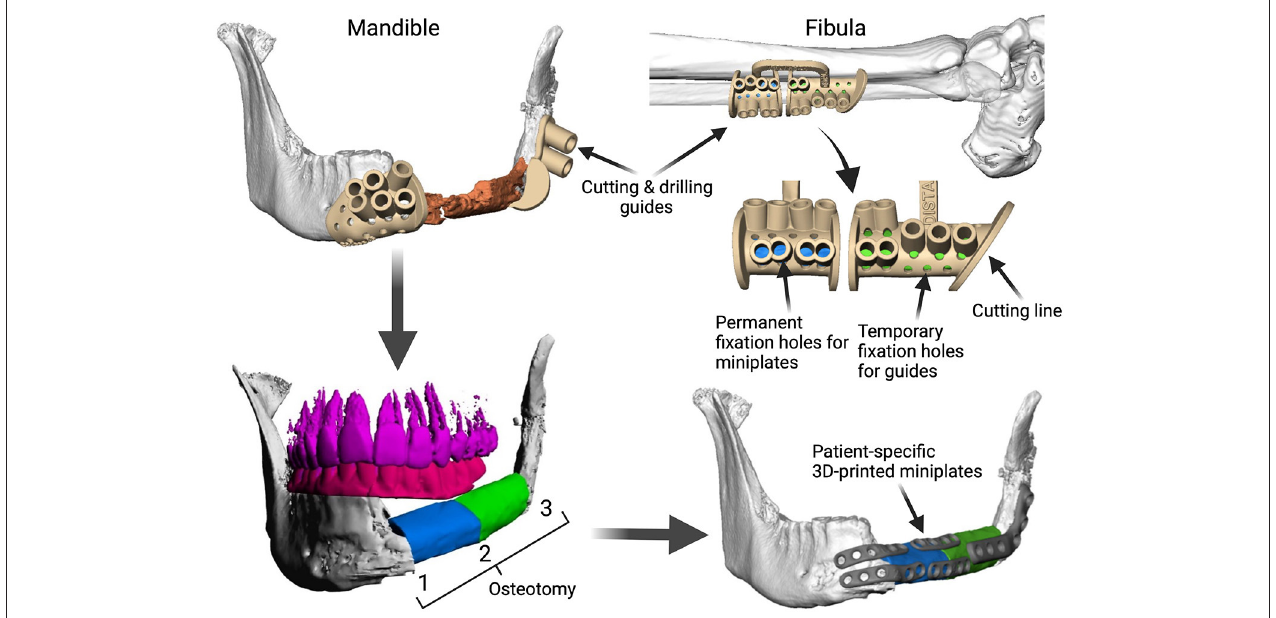
FIGURE 1 | Demonstration of the CAD/CAM-workflow: Cutting and drilling guides placed at the mandible defect (orange) and the fibula segments (green and blue). Guides include holes for temporary guide fixation as well as permanent holes for miniplates fixation. Bottom left: Visualization of the dentition of the upper jaw (violet) and dental setup of the lower dentition (pink) for planning of the dental implant insertion. Osteotomy lines 1, 2, and 3 are also shown. Final reconstruction results with patient-specific 3D-printed miniplates are demonstrated in the bottom right corner. Created with BioRender.com.